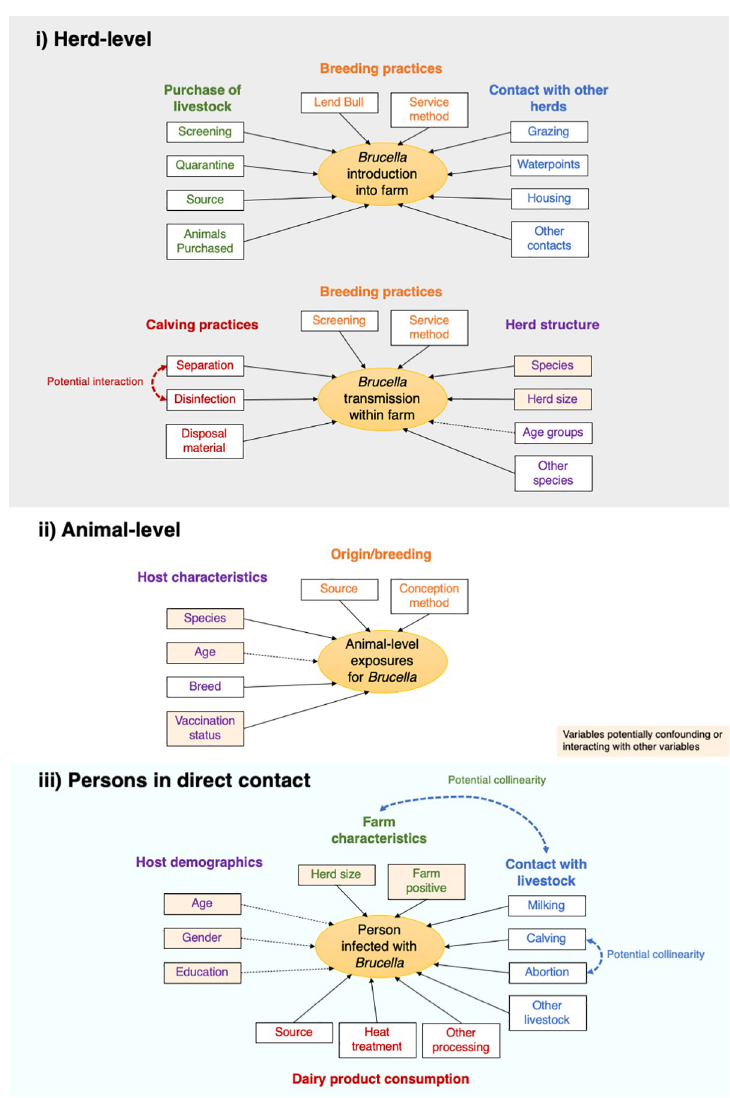
Fig 1. Conceptual diagram depicting the variables hypothesised to be associated with seropositivity in i) dairy farms ii) livestock and iii) persons in direct contact with livestock in the dairy farms. Data on these variables was gathered in the questionnaires and used in the statistical